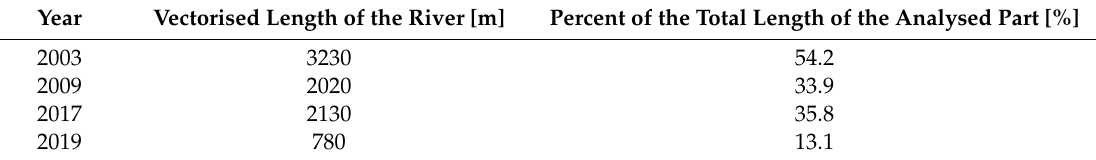
Table 2. Length of the river vectorised on the